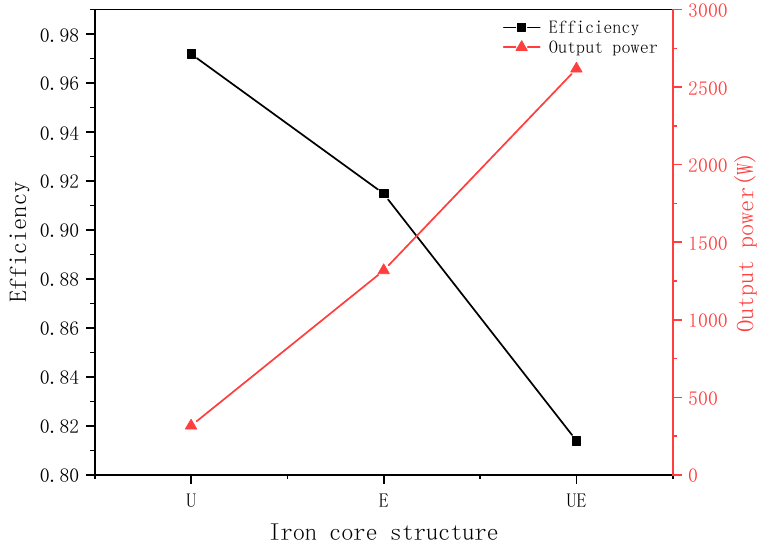
Figure 9. Output power and efficiency of ICPT systems with different magnetic coupling structures at resonance state.